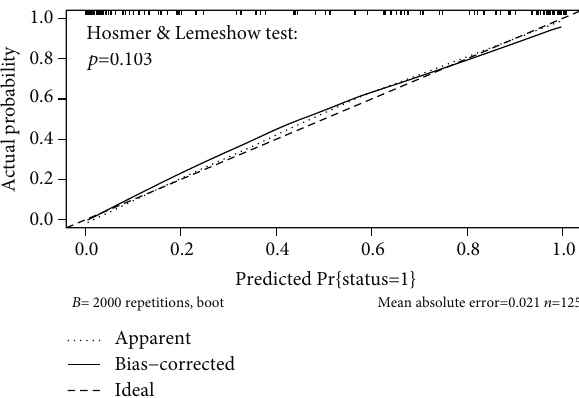
Figure 4: Calibration curves of the amputation risk in nomogram prediction. The thick dotted line represents an ideal prediction, and the thin dotted line represents the predictive ability of the nomogram. The closer the thick dotted line fi t is to the thin dotted line, the better the predictive accuracy of the nomogram